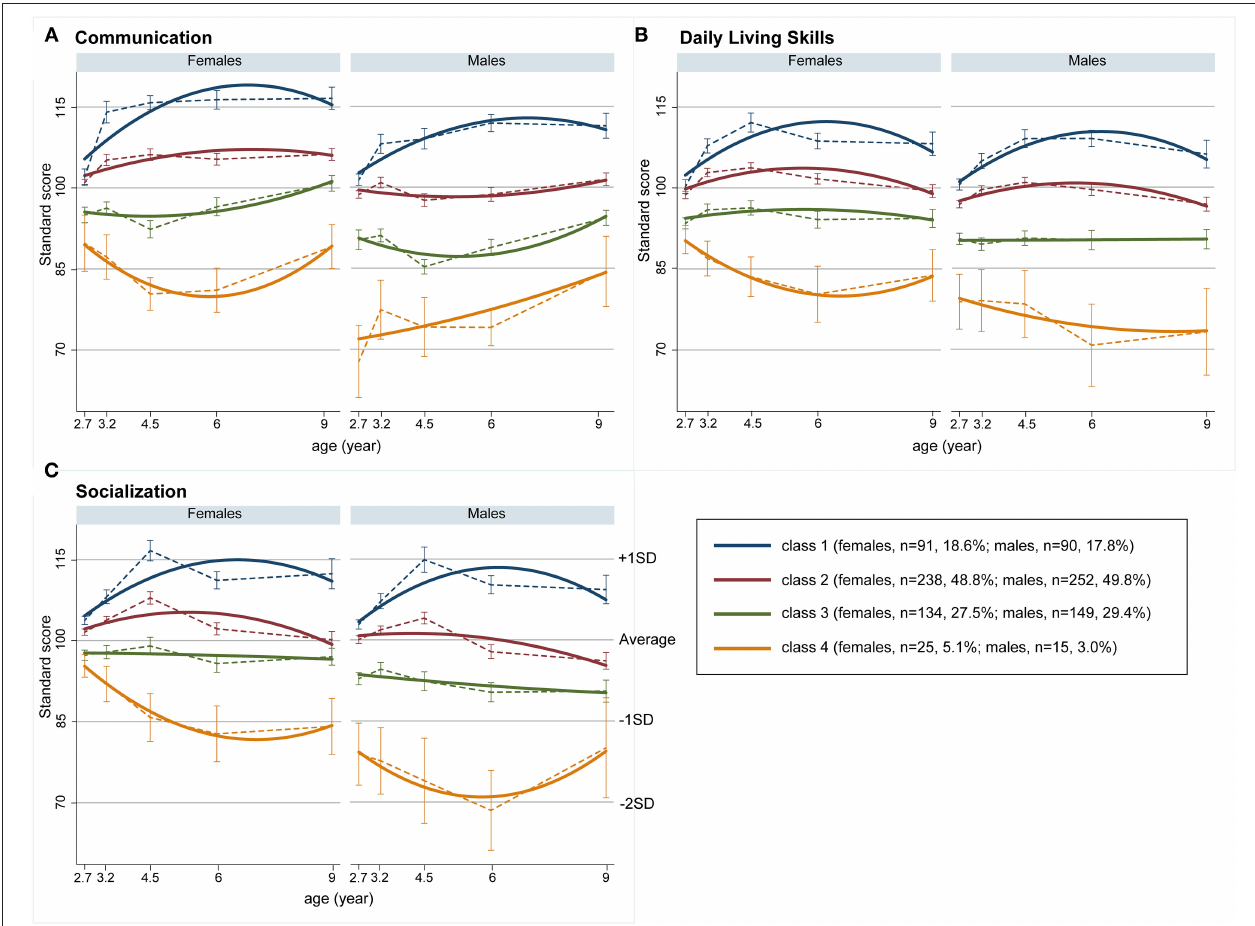
FIGURE 1 | Growth trajectories of adaptive behaviors. (A) Communication, (B) daily living skills, and (C) socialization; bold lines represent estimated trajectories and dashed lines represent observed trajectories; error bars represent standard errors.